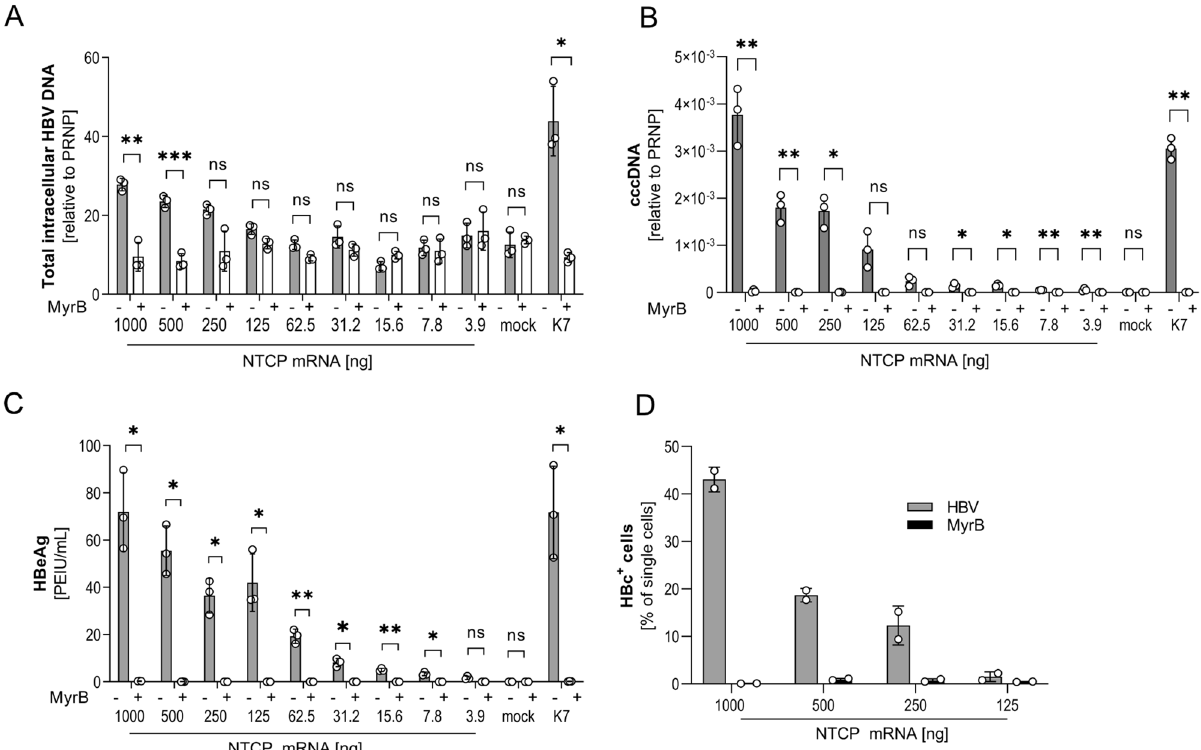
Figure 6. Susceptibility of HepG2 cells for HBV in relation to NTCP expression level. HepG2 cells were transfected with increasing doses of IVT mRNA encoding for NTCP as indicated. ( A ) Quantification of HBV uptake. Total intracellular HBV DNA was measured by qPCR relative to human prion protein PRNP 6 h post inoculation with WT HBV (MOI 200 virions/cell) in transfected HepG2 compared to HepG2-NTCP-K7 cell line. Treatment with 200 nM MyrB served as negative control. ( B ) Quantification of HBeAg secreted into the cell culture medium at 7 days post transfection. ( C ) Quantification of intracellular cccDNA by qPCR relative to human prion protein PRNP 7 days post inoculation. ( D ) To determine HBV infection rates, transfected HepG2 cells were infected with HBV at an MOI of 200 virions/cells and HBV core protein (HBc + ) expression was analyzed 7 days post infection by flow cytometry. Treatment with 200 nM MyrB served as negative control. In all experiments, mean ± SD of three biological triplicates ( A – C ) or biological duplicates ( D ) is shown. Statistical significance was determined using Welsh corrected Student’s t test (*p < 0.05, **p < 0.01, ***p < 0.001, ****p <